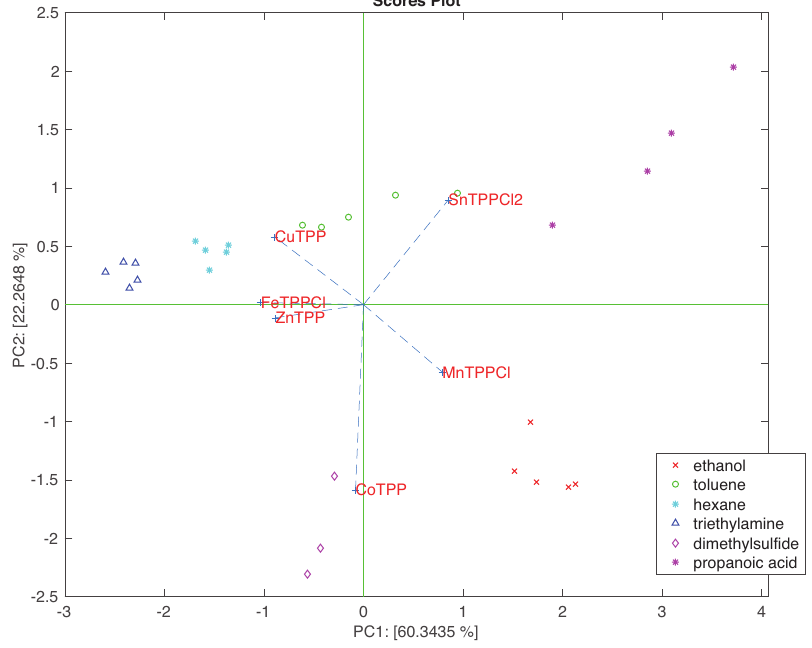
Figure 7. Biplot of the first two principal components of the linearly normalized sensors